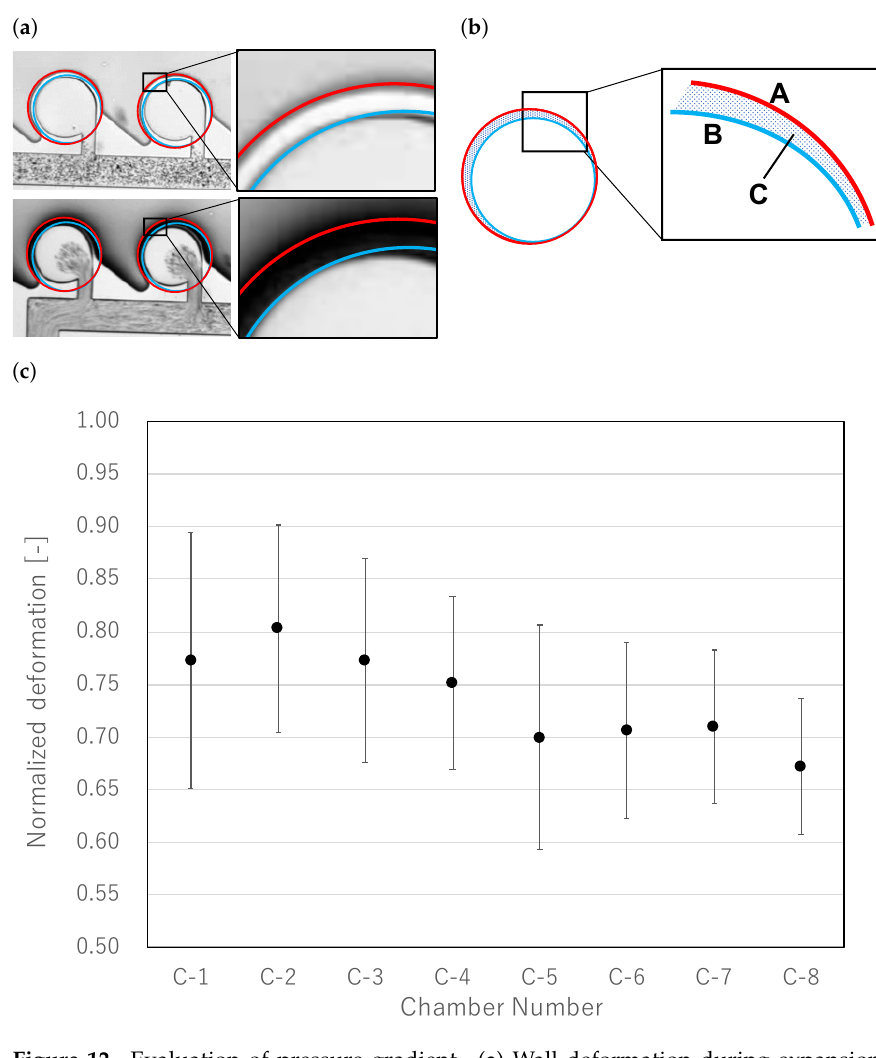
Figure 12. Evaluation of pressure gradient. ( a ) Wall deformation during expansion. Since the amount of deformation varied with the magnitude of pressure, it was used to evaluate the pressure gradient. ( b ) Details of evaluation region. Pixel values in Regions A and B were used to evaluate wall deformation in Region C. Equation (4) was used for evaluation. ( c ) Wall deformation in each chamber. Pressure gradients were generated approximately in the order of the concentration